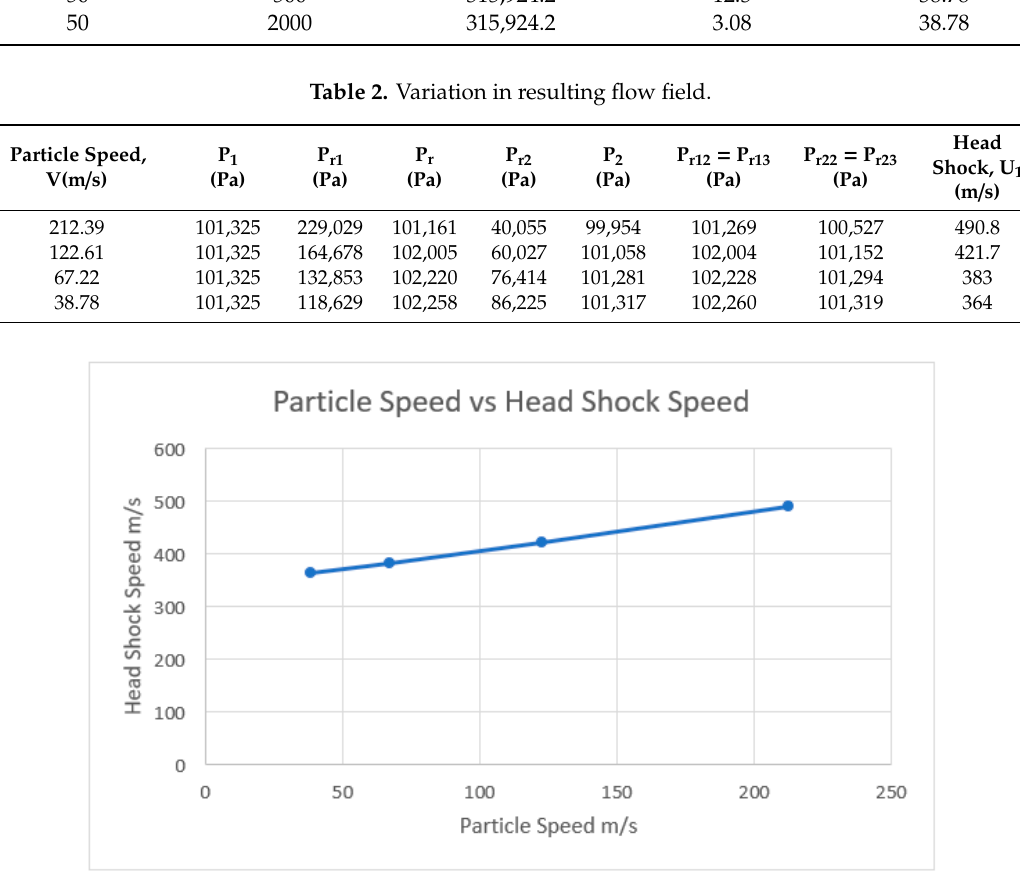
Figure 8. Particle speed vs. head shock.